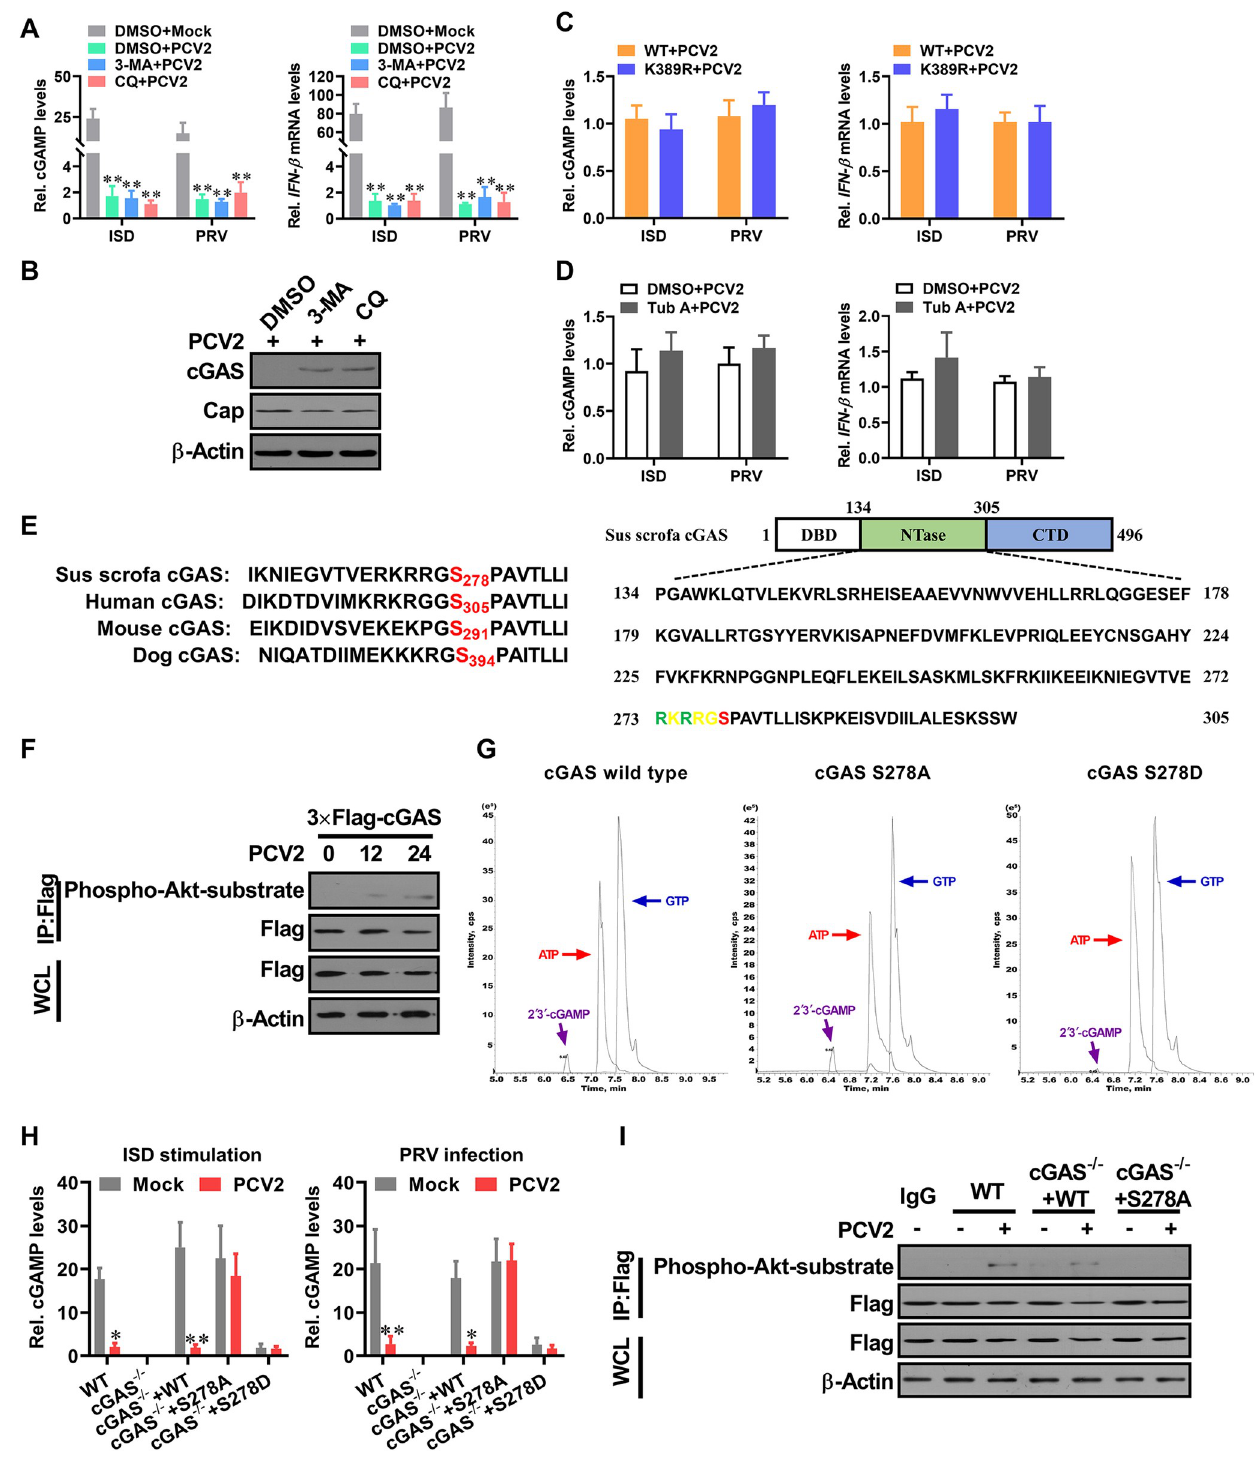
Fig 5. PCV2 induces phosphorylation of porcine cGAS at Ser278 to negatively regulate cGAS enzymatic activity. ( A, B ) Suppression of autophagic flux cannot effectively improve the induction of cGAMP and IFN- β in PCV2-infected cells. PK-15 cells pretreated with 3-MA or CQ were infected with PCV2 (MOI = 5) for 48 h, and then the relative cGAMP production levels and IFN- β mRNA levels at 6 h following ISD stimulation or PRV infection were determined by report assay and qPCR respectively (A). �� P < 0.01 (compared with mock infection). The levels of porcine cGAS and PCV2 capsid were determined by western blotting (B). (C) The cGAS -/- PK-15 cells were reconstituted with the wild type cGAS, mutant cGAS (K389R), respectively, then